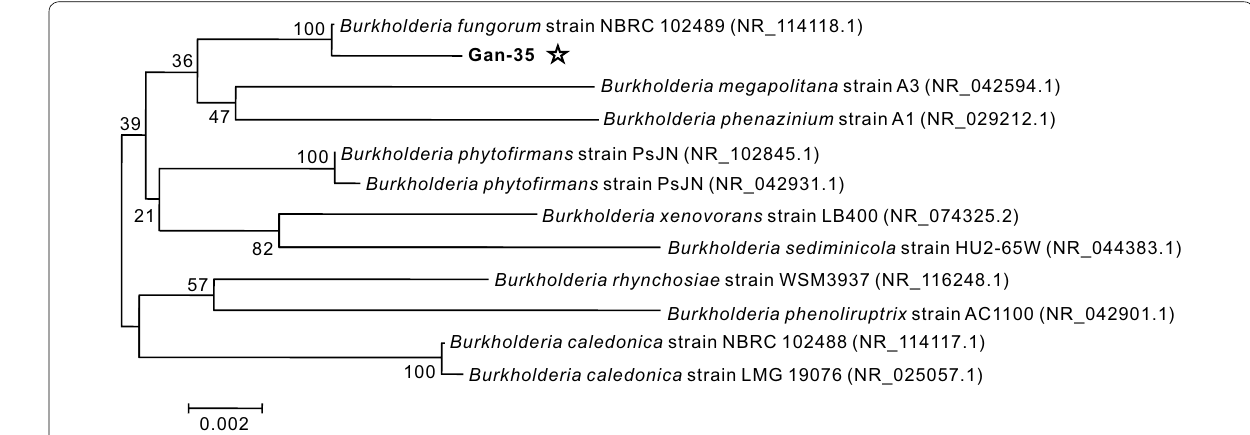
Fig. 4 Phylogenetic analysis using 16S rDNA sequences. The accession numbers of the 16S rDNA sequences are presented in the parentheses. Strain Gan‑35 is indicated by a